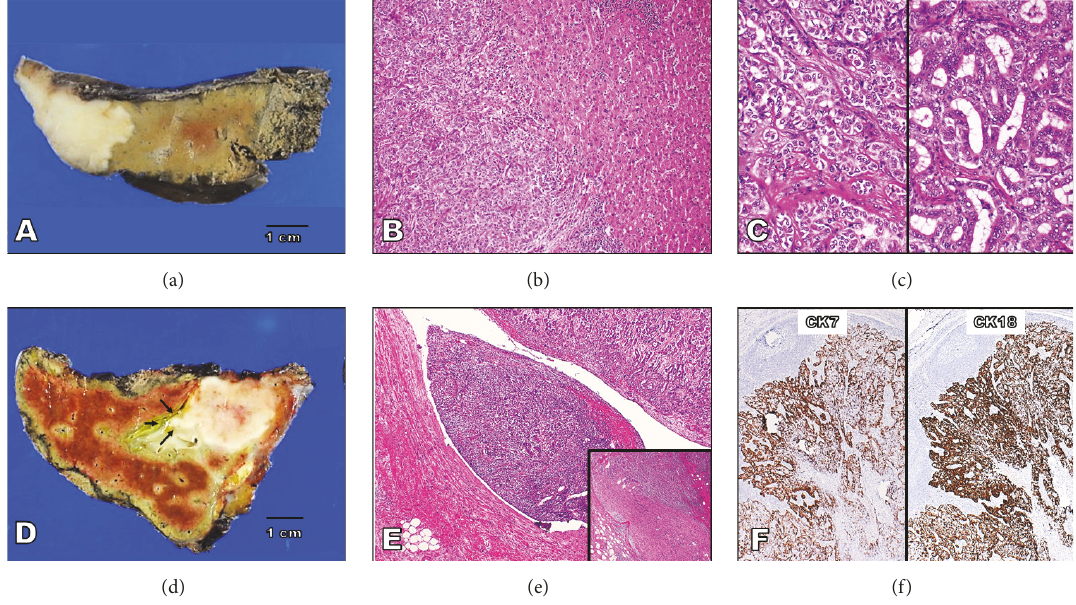
Figure 1: The gross, microscopic, and immunohistochemical examinations of the primary CHC-INT . (a) The cut surface of the first CHC-INT case characteristically shows a poorly demarcated peripheral nodule in lobulated margins, measuring 32 x 21mm in diameter, which appears clearly whitish in color. Bar = 1cm. (b) A microscopic examination of the first CHC-INT case (H&E staining) demonstrates an unencapsulated,ill-defined,andexpansivenodule(leftside),arrangedpredominantlyinaproliferationofsolidnestspattern(leftside).(c)The first CHC-INT (H&E staining) shows a solid proliferation of atypical epithelial cells, forming trabeculae (left panel) and/or ill-defined, fused tubule-like structures (right panel). These atypical cells are small-to-medium-sized and relatively uniform, having enlarged hyperchromatic nuclei and scant cytoplasm. (d) The cut surface of the second CHC-INT case characteristically reveals a poorly demarcated portal nodule in lobulated margins with central necrosis, measuring 35 x 26mm in diameter, which appears clearly whitish in color, accompanied by portal vein permeation (arrows). Bar = 1cm. (e) A microscopic examination of the second unencapsulated CHC-INT tumor (H&E staining) shows a solid proliferation of atypical epithelial cells, arranged predominantly in solid nests, trabeculae, and/or irregular and fused tubule-like structures, aggressively involving the portal vein (right upper side to center) with focal perineural invasion (inset). Left lower side is the intact wall of the portal vein. (f) Immunohistochemistry demonstrates that those second CHC-INT carcinoma cells are specifically positive for not only CK7 (left; cholangiocytes marker) but also CK18 (marker for both hepatocytes and